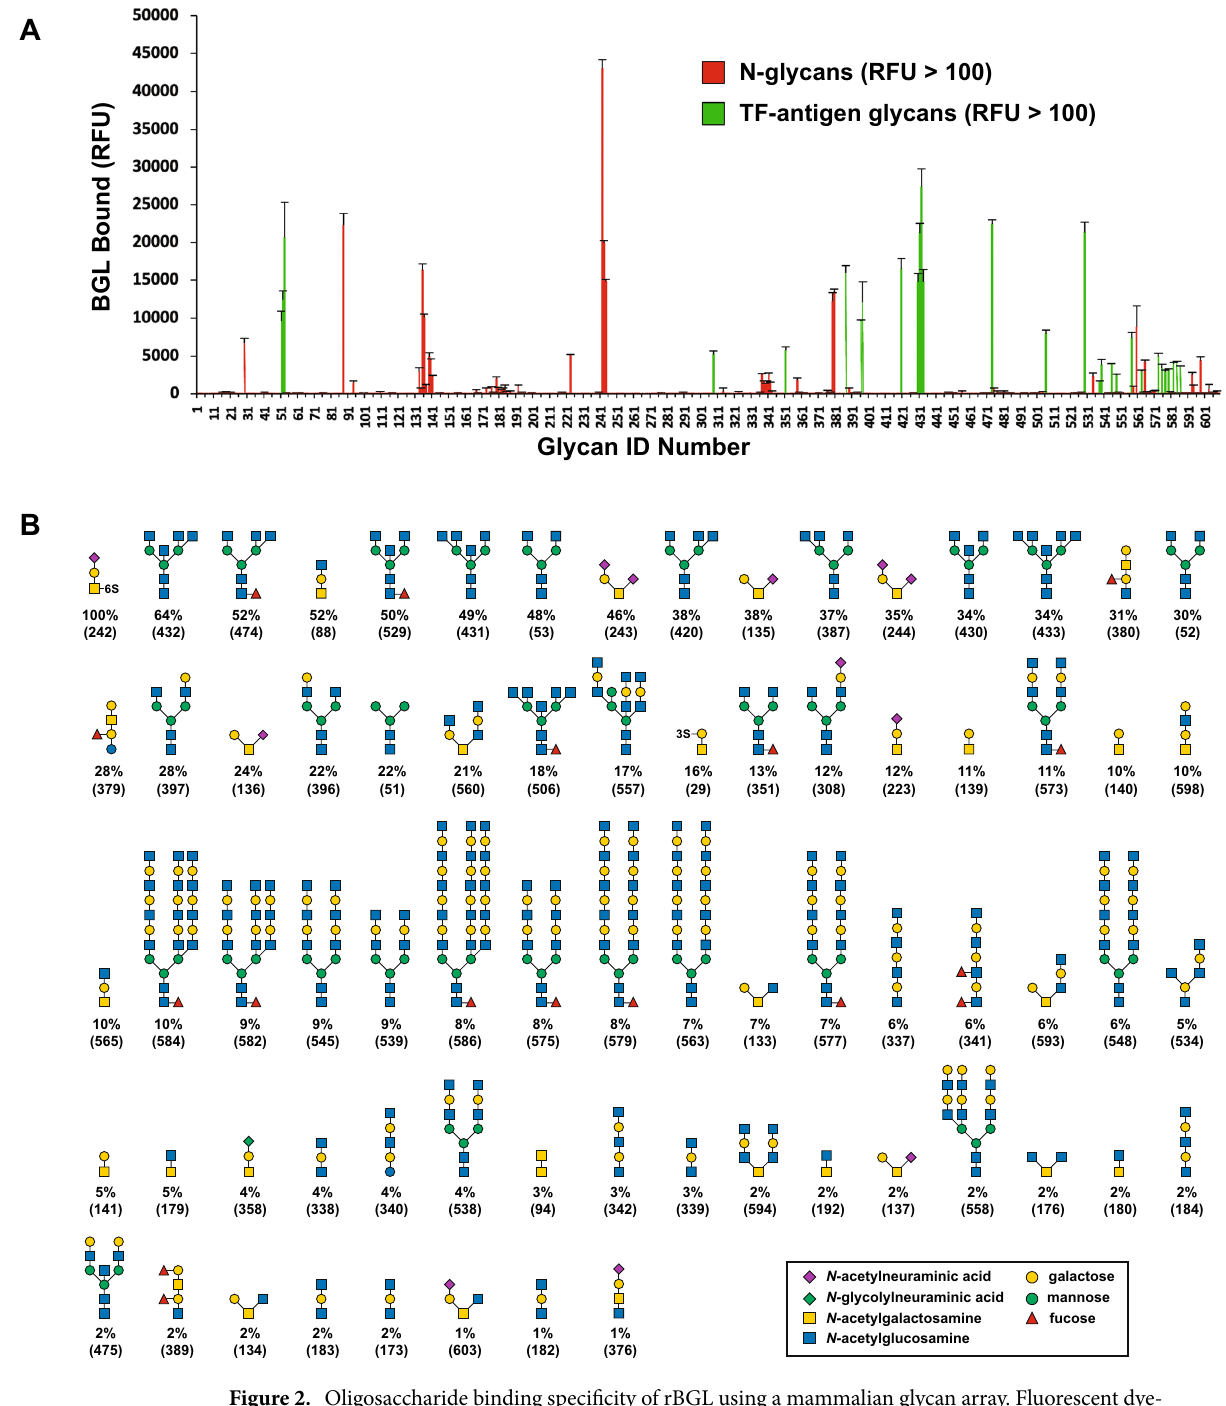
Figure 2. Oligosaccharide binding specificity of rBGL using a mammalian glycan array. Fluorescent dye- labeled rBGL (200 μg/mL) was used for glycan array screening at the Protein–Glycan Interaction Core H of the Consortium for Functional Glycomics (CFG). ( A ) The specificity of rBGL was determined by testing its ability to bind to a printed array (version 5.2) consisting of 609 mammalian glycans. Two distinct classes of glycan were bound; N - glycans having terminal GlcNAc (green bars) and glycans predominantly containing the TF-antigen disaccharide Galβ1,3GalNAc (red bars). ( B ) The structures of oligosaccharides bound by rBGL are shown in decreasing order of ligand binding efficiency down to 1% binding relative to the strongest signal (see Supplementary Table 1 for raw array data). The CFG array’s Glycan ID numbers for each structure are shown in parentheses. Structures appearing more than once reflect identical glycans in the array that possess different chemical linkers. RFU relative fluorescence